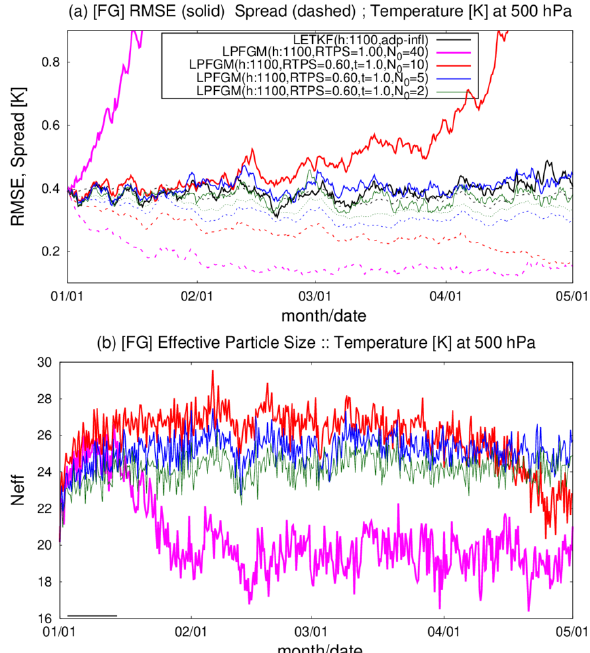
Figure 11. Similar to Fig. 8 but showing the LPFGM experiments with the RAOB and 1100km localization scale. Magenta, red, blue, and green lines are LPFGM experiments with N 0 = 40, 10, 5, and 2, respectively. Forgetting factor τ is 1.0. The RTPS parameter is set to 1.00 in the experiment with N 0 = 40 (i.e., all-time resampling) and to 0.60 for in other